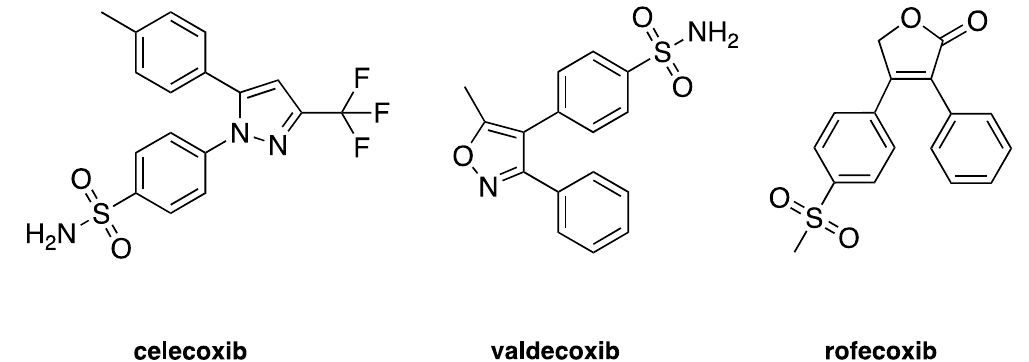
Figure 1. Two-dimensional (2D) chemical structures of cyclooxygenase-2 (COX-2) inhibitors celecoxib, valdecoxib, and rofecoxib.